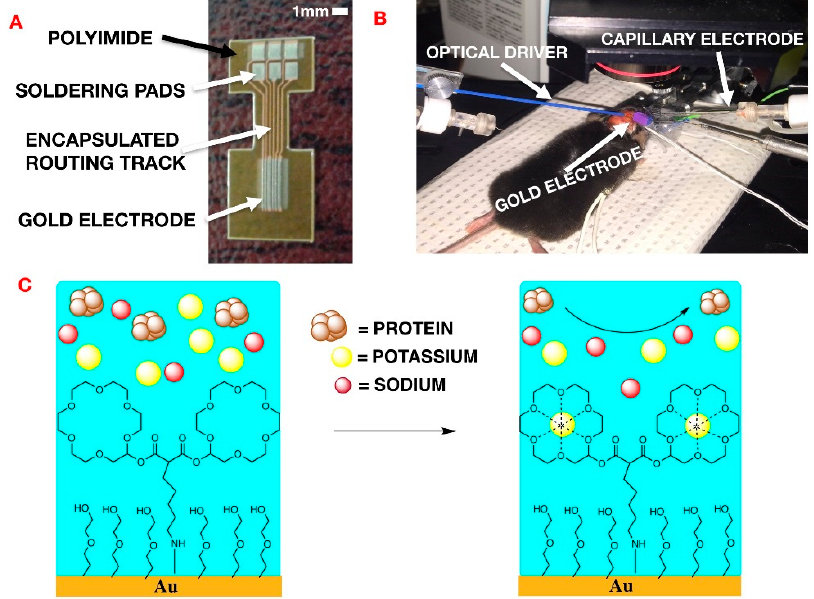
Figure 1. ( A ) design of multichannel gold microelectrode. It consists of a plastic film coated with gold and etched using photolithography to produce 6 pads; ( B ) experimental set-up of extracellular potassium on mouse cranium. K + -sensitive glass capillary electrode, reference electrode and gold-coated microelectrode were placed with 3 mm of each other in a 1 × 1 cm section of exposed cortex. Blue light stimulation was performed equidistant (1 cm) from both electrodes; and ( C ) overall 2D scheme of coated gold microelectrode. The mixed ultrathin monolayer consists of a modified 18-6-crown-ether and monoethyleneglycolthiol (MEG-SH) in 1:10 ratio, respectively.